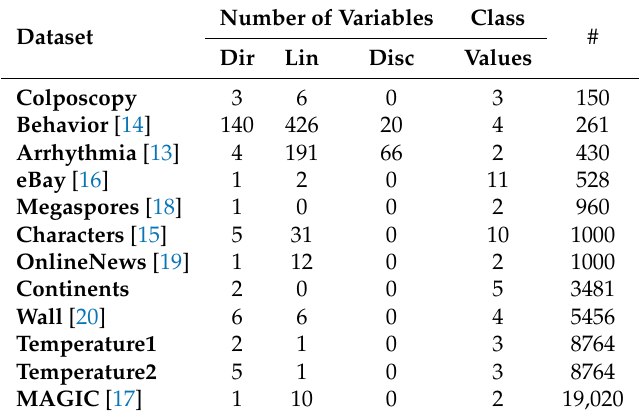
Table A1. Number of variables, number of classes and cardinality of each dataset. Variables are divided into the respective types: directional (Dir), linear (Lin) and discrete